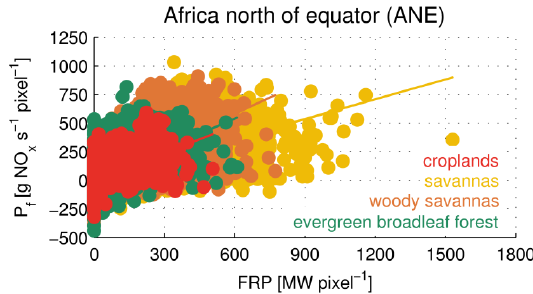
Fig. 10. Biome-specific FERs of NO x for ANE. Here, the best Figure 10. Biome-specific FERs of NO x for ANE. Here, the best fitting least-squares regression 2 fitting least-squares regression lines of the morning observations lines of the morning observations (GOME-2 vs. MODIS Terra) are shown for evergreen 3 (GOME-2 vs. MODIS Terra) are shown for evergreen broadleaf for- est (green), woody savannas (orange), savannas (yellow), and crop- broadleaf forest (green), woody savannas (orange), savannas (yellow), and croplands (red). 4 lands